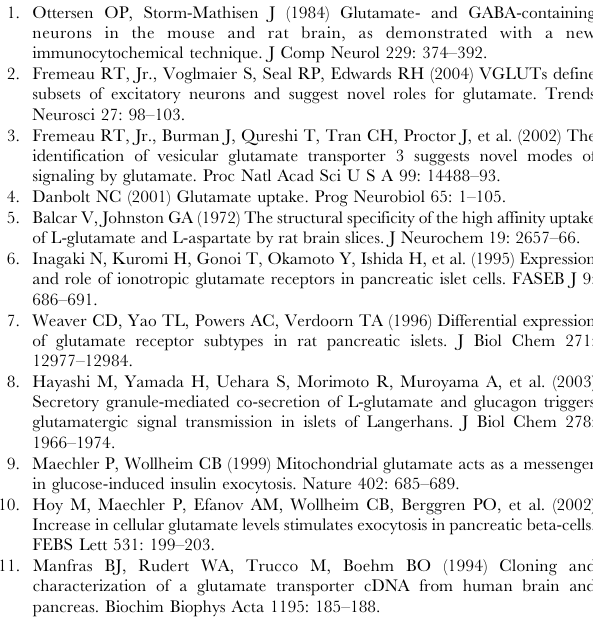
Figure S2 To examine whether EAAT2 affects insulin secretion in intact animals, we analysed insulin serum concentrations in